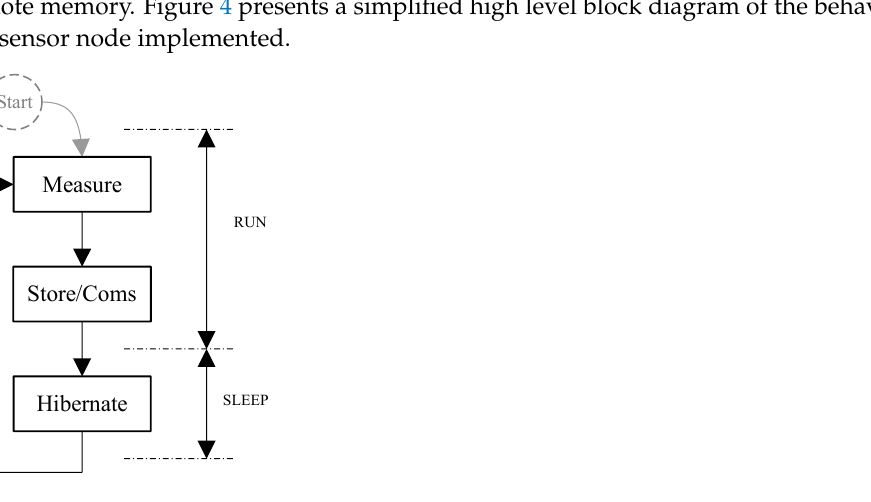
Figure 4. Simplified high level block diagram of the behavior of the sensor